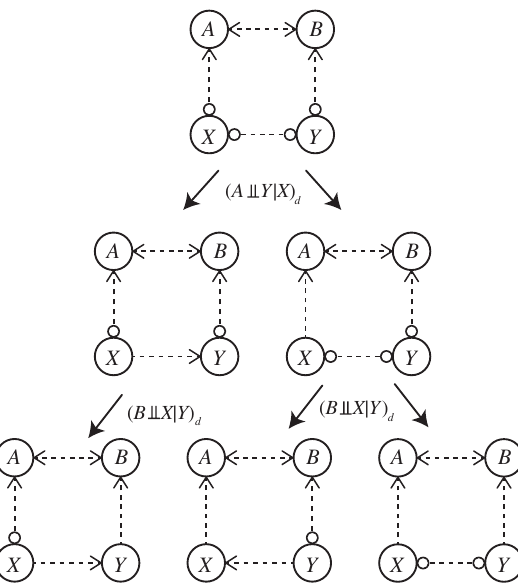
FIG. 14. DAG elimination in step 4. In step 5 we show that the three remaining classes of DAGs are